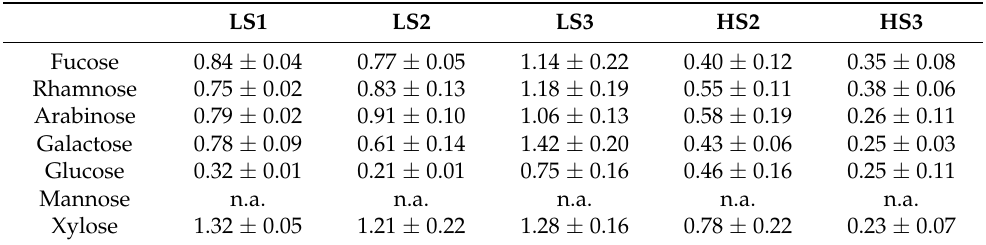
Table 6. Enrichment factors of individual neutral aldose in the particulate phase. LS and HS denote low- and high-salinity,